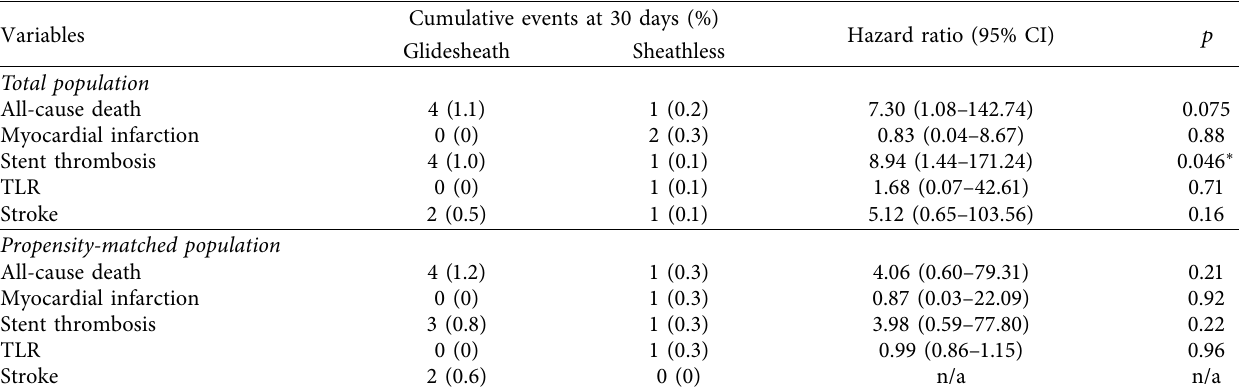
Table 6: Thirty-day clinical outcomes by Cox proportional hazard ratio model